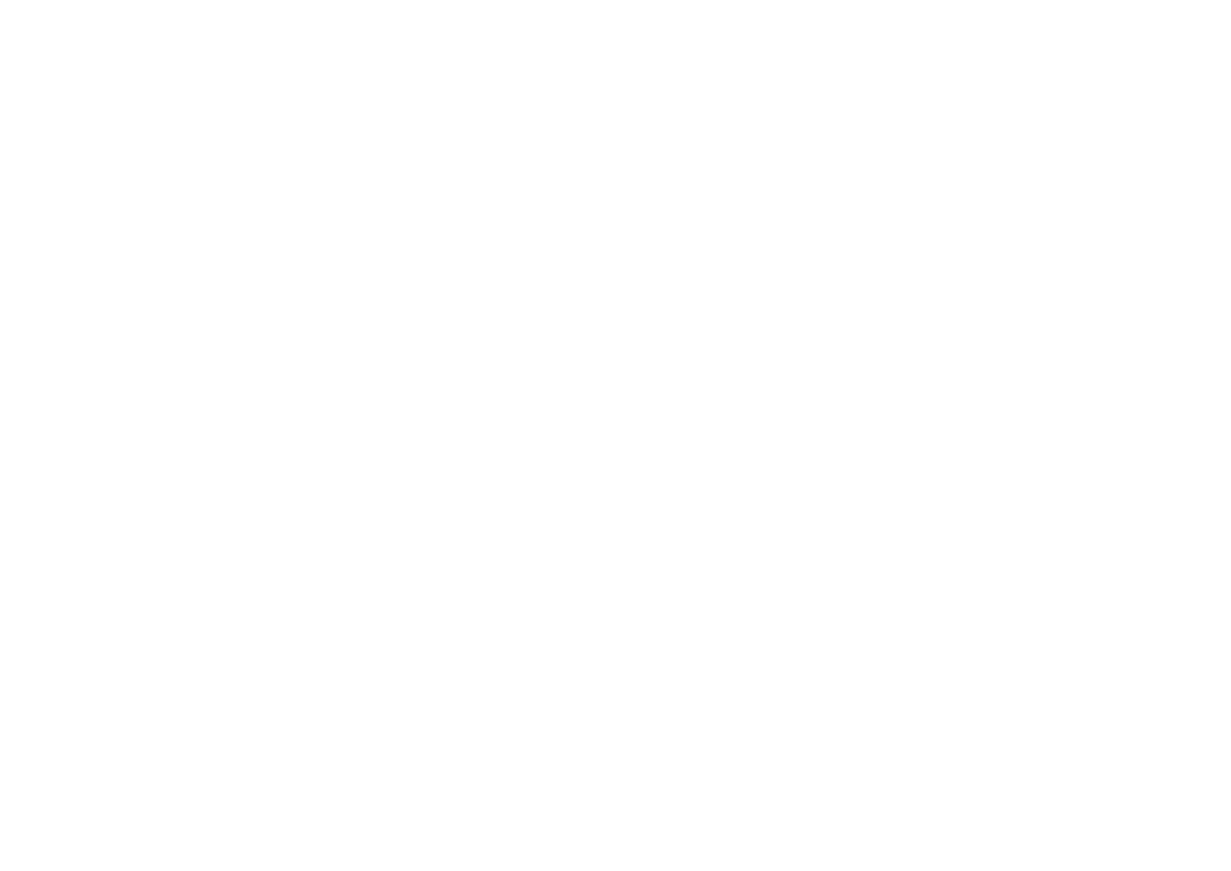
FIGUREA2 | Receptive field of vCH in Eristalis and Calliphora . Each plot shows the receptive field of vCH in a window of > 140˚ elevation and > 160˚ azimuth.The false color map behind the local preferred directions codes for the mean response amplitude of the cells to movement from the left to the right at seven different elevations.The false color map was interpolated to avoid hard edges of binning the data.The superimposed arrows show the local preferred directions (length codes for local sensitivity). Black arrows are samples. Gray arrows are linearly interpolated.To determine the receptive fields a narrow but high (2˚ × 10˚) target was presented to vCH neurons which traversed the complete field of view horizontally at seven different elevations in both directions. In addition, the same target, rotated by 90˚, was presented on a vertical trajectory at seven different azimuths. The local direction preference of the vCH cell ( FigureA2 ) was calculated